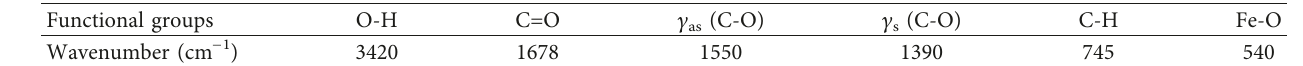
Figure 3: X-ray diffraction patterns (a) and FT-IR spectra of MIL-53(Fe) (b). Table 2: The surface functional groups analysis of